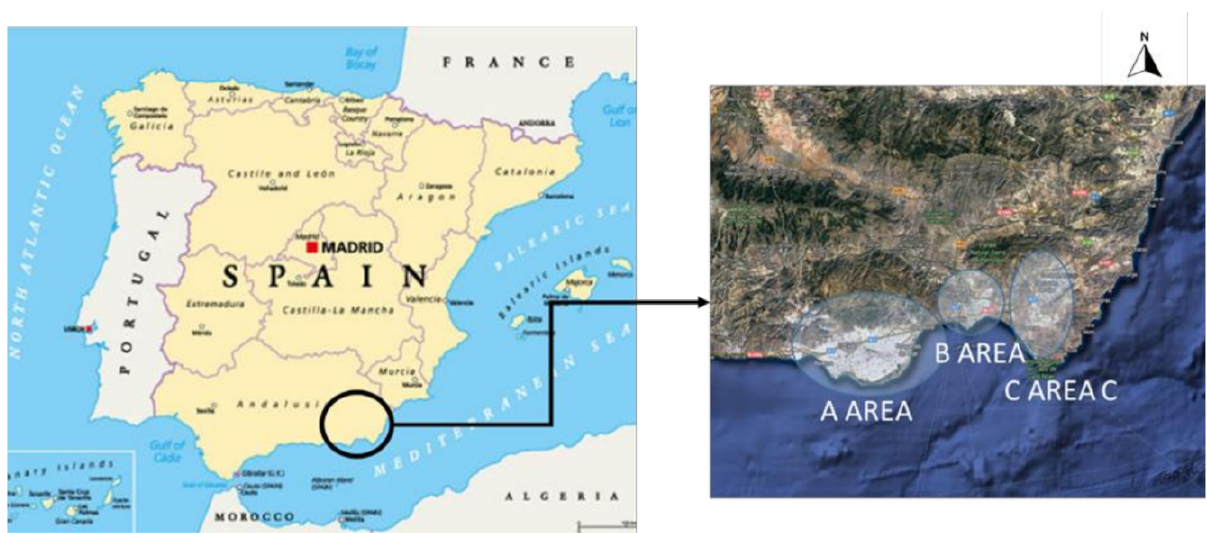
Figure 1. Study areas included in the